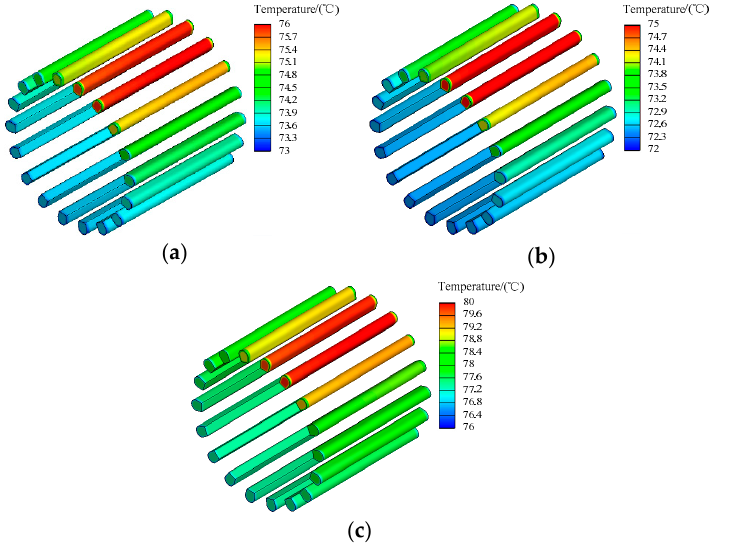
Figure 18. Temperature distribution of the equivalent stator winding: ( a ) Healthy motor cage; ( b ) One-broken-bar fault; ( c ) Continuous two-broken-bars.